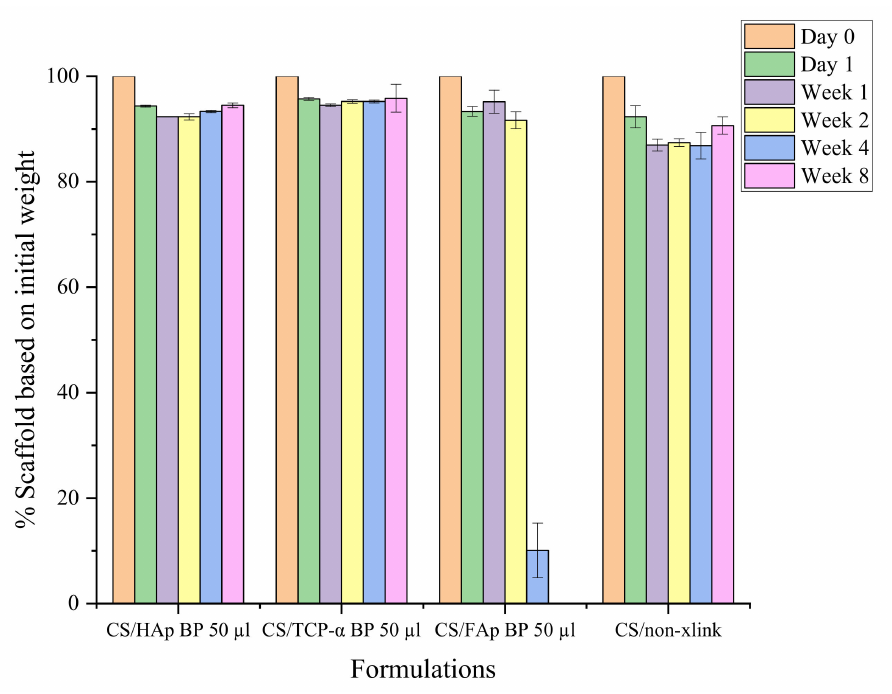
Figure 7. The degradation profile of the chitosan scaffolds in simulated body fluid over eight weeks shows a similar degradation rate for chitosan scaffolds with HAp, TCP- α and FAp ceramics. Additionally, BP loading also affected the degradation rate of the scaffold (Figure